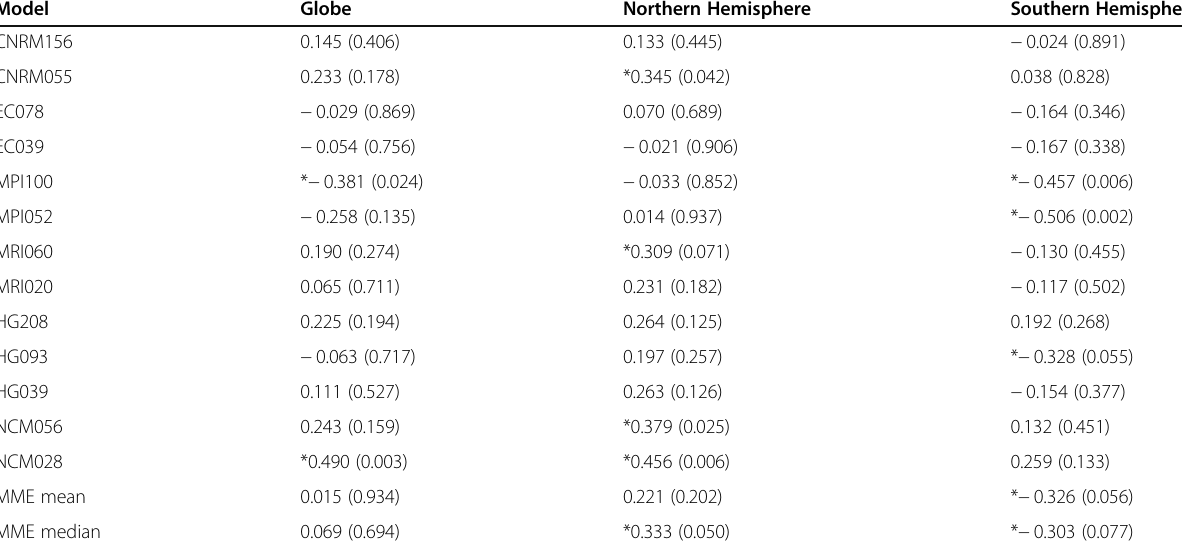
Table 4 Spearman ’ s rank correlations between TC seed frequencies in HighResMIP multi models and in JRA-55. Spearman ’ s rank correlations were calculated from 1980 to 2014. An asterisk indicates that a correlation is statistically significant at the 90% confidence level (at least). P values are indicated in parentheses Model Globe Northern Hemisphere Southern